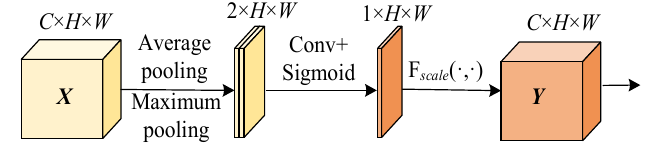
Figure 4. Spatial attention module.